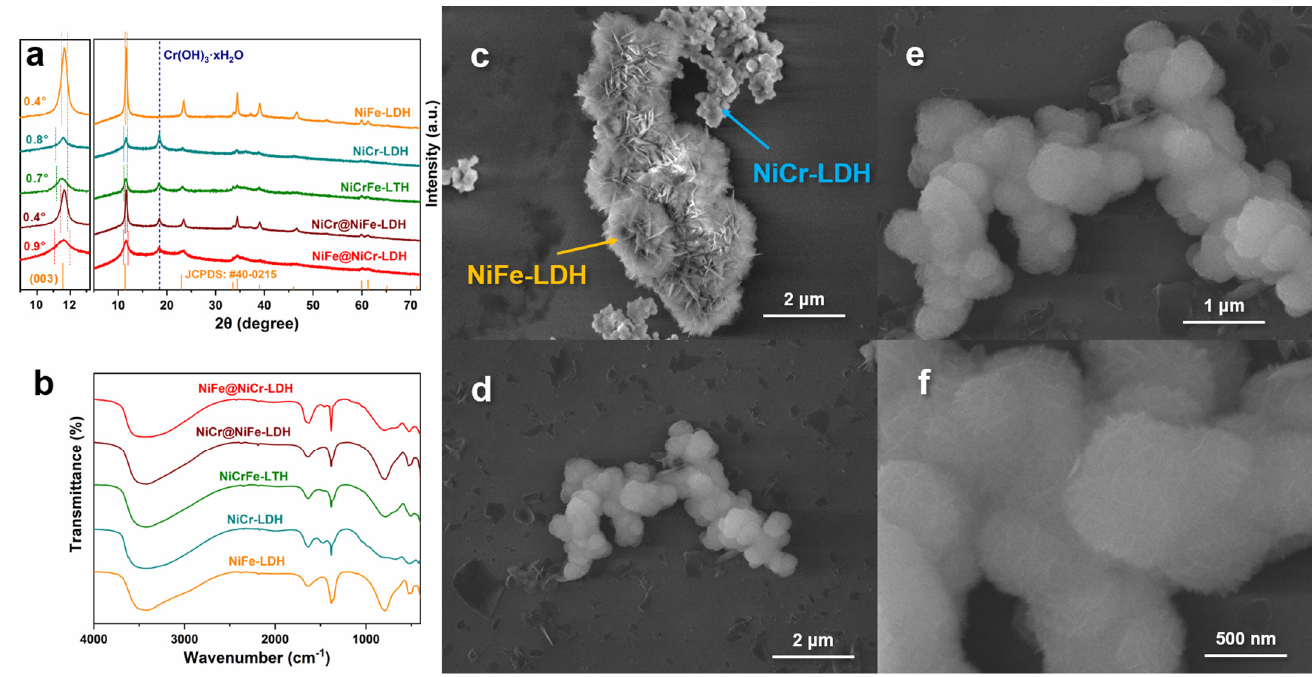
Figure 1. ( a ) XRD patterns of NiFe@NiCr-LDH, NiCr@NiFe-LDH, NiCrFe-LTH, NiCr-LDH, and NiFe-LDH, with FWHM values of LDHs’ (003) peaks; ( b ) FTIR spectra of the as-prepared LDH samples; ( c ) Typical SEM images of NiFe-LDH/NiCr-LDH; ( d – f ) Typical SEM images of NiFe@NiCr-LDH with di ff erent magni fi cations.